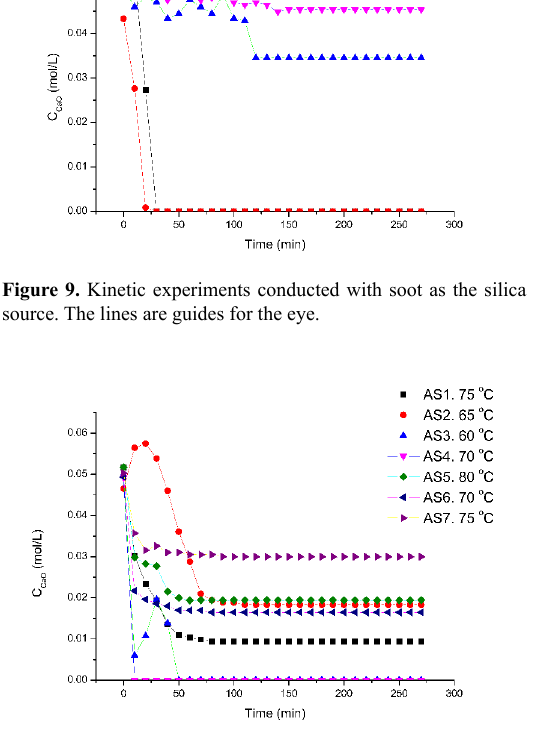
Figure 10. Kinetic experiments conducted with active silica as the silica source. The lines are guides for the eye.